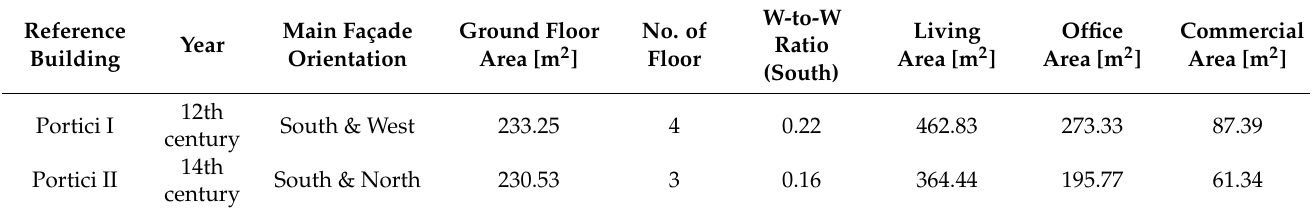
Table 3. Key architectural details of the reference buildings. W-to-W ratio = window-to-wall ratio.